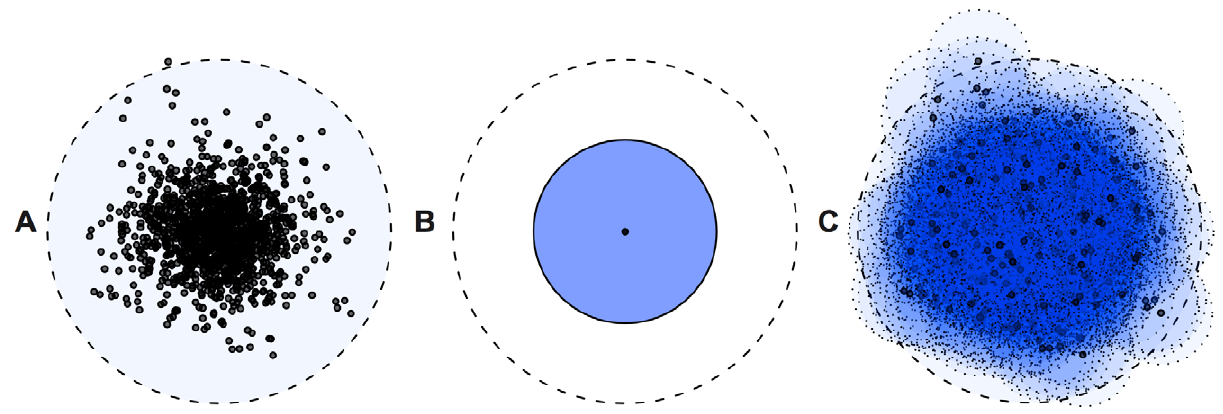
Figure 1. Principles of repeat identification using P -clouds. A) True data distribution representing divergence within a TE family from a master element sequence (center). B) Consensus sequence based search throws away information by collapsing observed data to a single sequence. C) P-clouds clusters related high-abundance oligos, thus providing better coverage of sequence space.